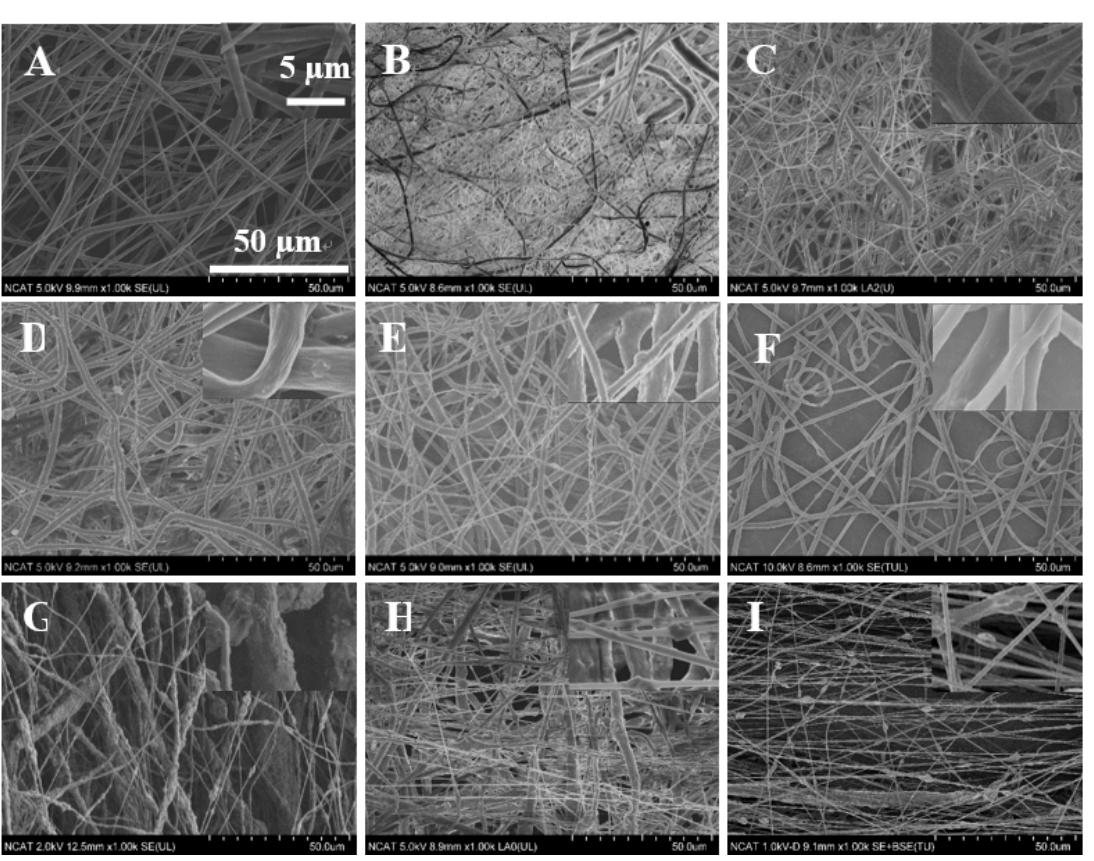
Figure 1. SEM images of electrospun nanofibers of poly( ε -caprolactone) (PCL)/MgO with ratios of ( A ) 1:0, ( B ) 1:0.05, ( C ) 1:0.10, ( D ) 1:0.20, ( E ) 1:0.50, ( F ) 1:1, ( G ) 1:1.5, ( H ) 1:2; and PCL-K/MgO ( I ) 1:1. The insets show higher magnification images of each corresponding SEM images. The scale bar in the inset represent 5 µm for the insets; scale units for the lower magnification are on the figures ( i.e. , 50